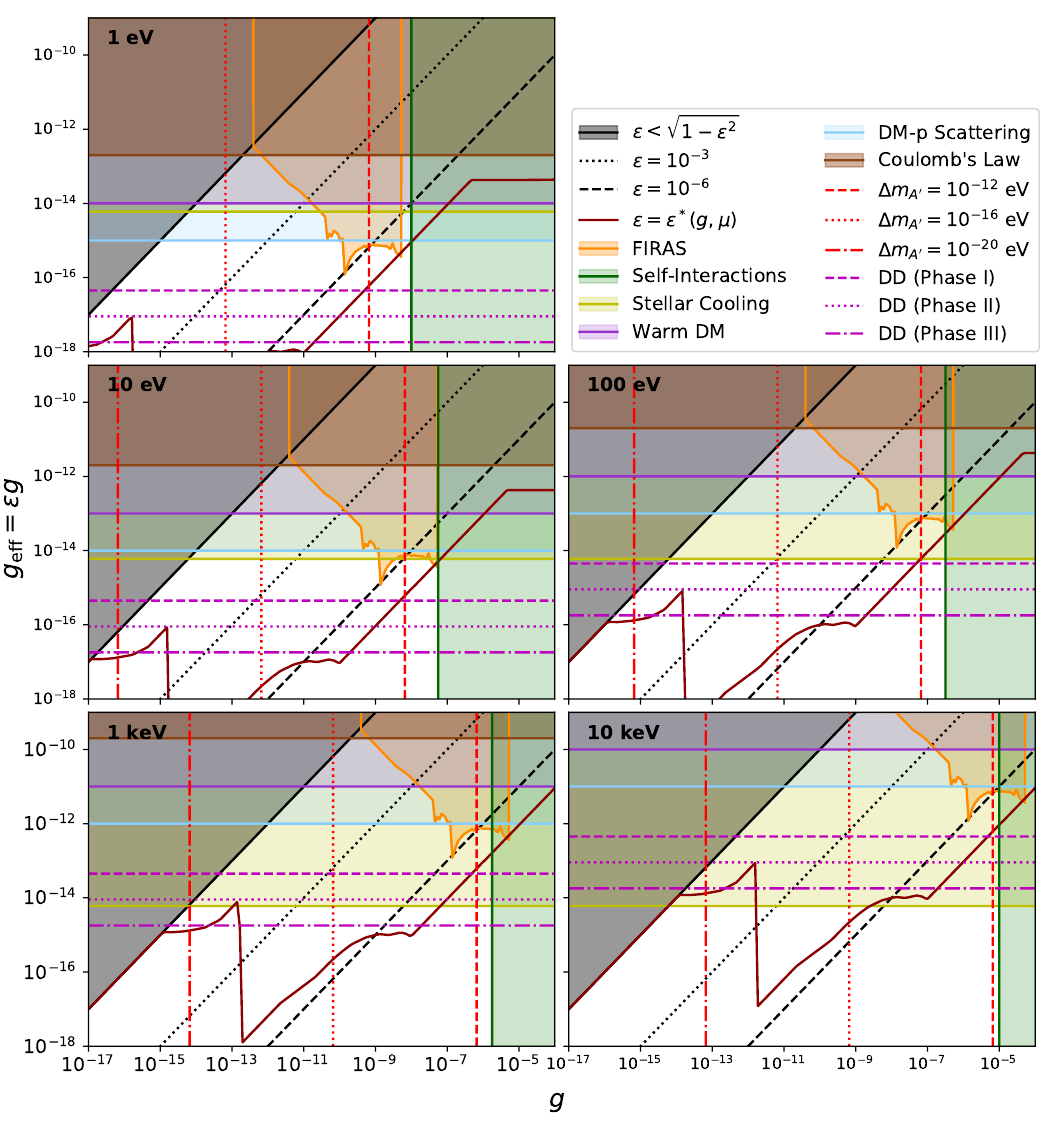
Figure 4 . Constraints on the possible values of g eff = (cid:15)g as a function of g for a hidden photon- coupled χ field with masses from 1 eV to 10 keV. Shown are several existing bounds discussed in the text, as well as the projected reach of a direct deflection experiment [10], including the three sets of parameters discussed in that reference. The FIRAS bound diverges at its high- g edge, though this divergence is not shown as it is extremely narrow and is difficult to estimate numerically. Also shown are the values of g corresponding to local hidden photon plasma masses of 10 − 12 , 10 − 16 and 10 − 20 eV, which may correspond to additional constraints from black hole superradiance. Four √ lines corresponding to values of (cid:15) are included: (cid:15)/ 1 − (cid:15) 2 < 1 and (cid:15) = 10 − (3 , 6) for reference (see e.g. [56] for a summary of current and expected future constraints on the hidden photon kinetic mixing), and (cid:15) = (cid:15) ∗ ( g, µ ) where (cid:15) ∗ ( g, µ ) is the largest kinetic mixing allowed by those constraints at masses large enough to avoid plasma instabilities [57]. Note that none of these (cid:15) lines are current constraints, but they may lead to constraints if plasma instabilities are excluded in the